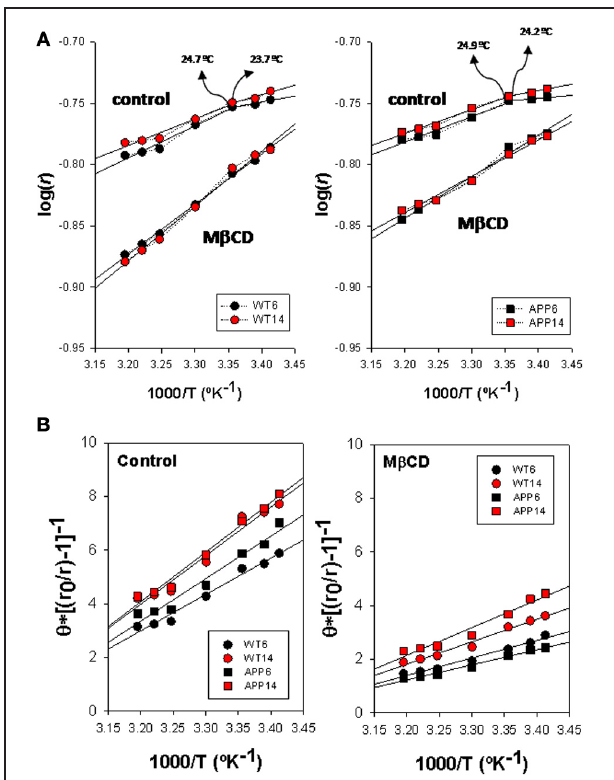
FIGURE 4 | Biophysical characterization of lipid rafts from APP/PS1 and WT brain cortex probed with DPH. (A) Arrhenius plots for steady-state anisotropy in WT (left) and APP/PS1 (right) animals. (B) Microviscosity analyses based on modified Perrin equation for steady-state fluorescence anisotropy for DPH under control (left panel) and after M β CD treatment (right panel). Discontinuity temperatures ( Td ) are indicated.